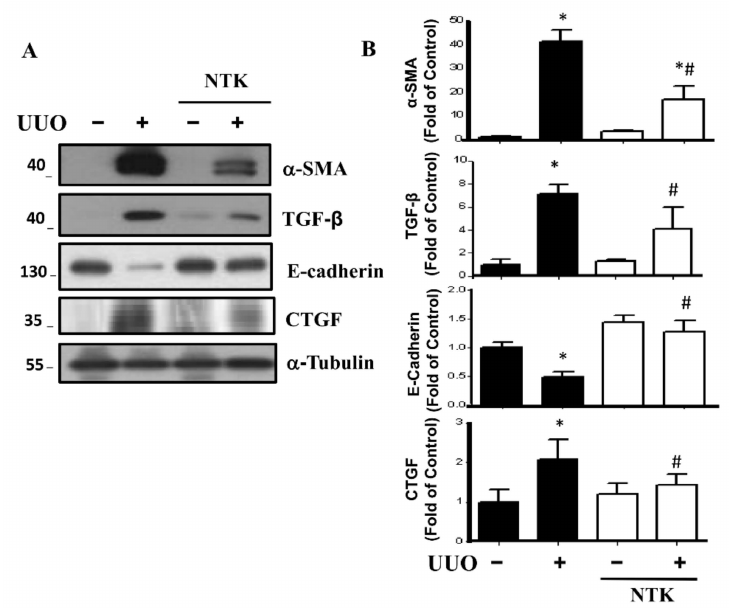
Figure 4. Effects of Nootkatone treatment on the renal fibrosis in the UUO kidneys. Vehicle or Nootkatone (NKT) was orally given to the sham or UUO mice for 14 days. Protein expression levels of the fibrotic signaling markers were determined by Western blotting ( A ). The quantification is shown in ( B ). Data are presented as mean ± SD ( n = 6). * p < 0.05 vs. the sham control group. # p < 0.05 vs. the UUO